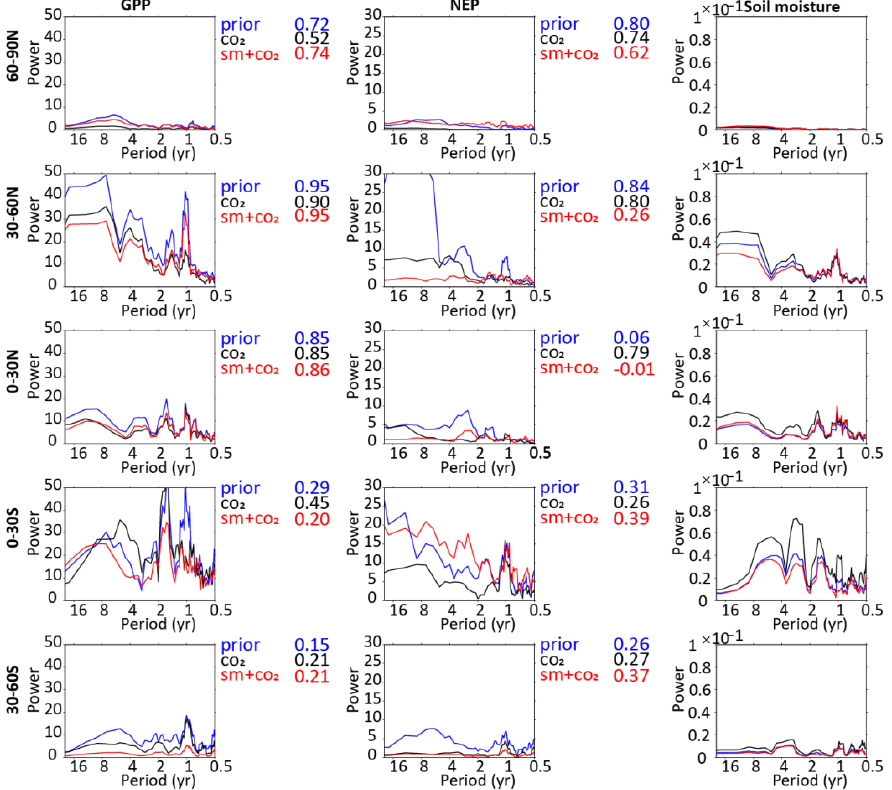
Figure A6. The power spectra of simulated GPP and NEP (by column) with different experiments (by color) in different latitude bands (by row). The mean seasonal cycle of all monthly variables is removed. GPP for gross primary productivity, NEP for net ecosystem productivity. Blue color denotes results from the prior model simulation with prescribed parameter values, black color denotes the atmospheric CO 2 only assimilation results, and red color denotes the results from the simultaneous assimilation of soil moisture and atmospheric CO 2 . The colored digits in each panel denote the Pearson r of spectra pattern between soil moisture (3rd column) and other variables (1st and 2nd columns) from different simulation experiments.